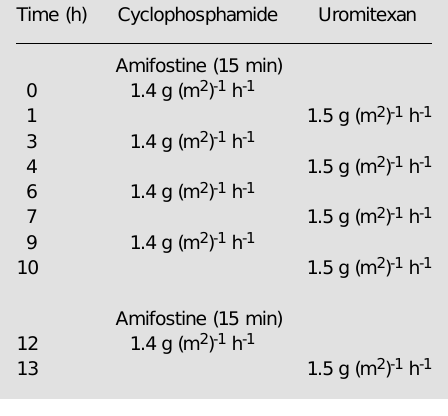
Table 1 - Time schedule for the administration of high-dose cyclophosphamide (7 g/m 2 ) and amifos- tine protection. Hyperhydration plus furosemide and acetazola- mide was used as previous support therapy. The standard dose of amifostine was 740 mg/m 2 . A dose of 910 mg/m 2 was used in high-risk patients.